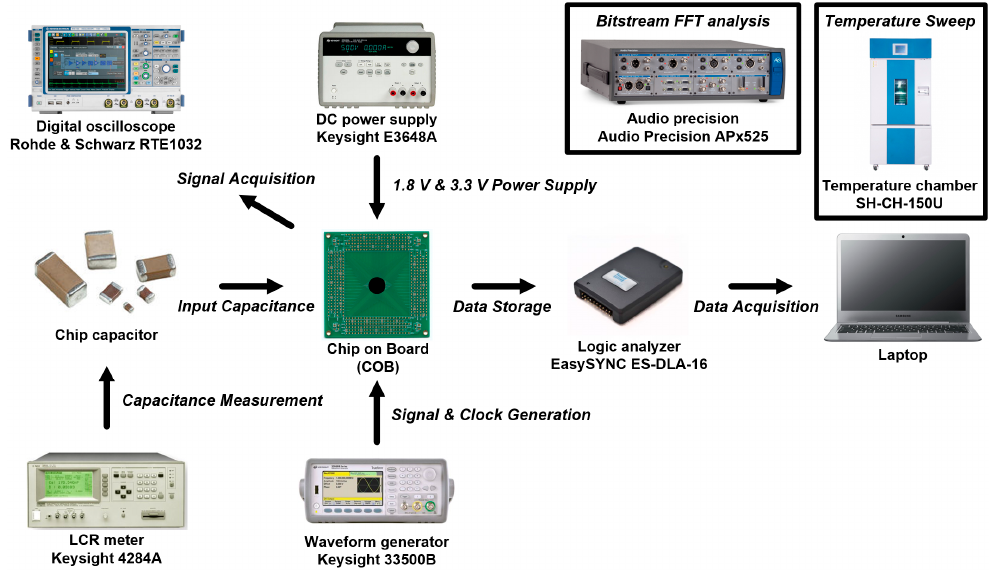
Figure 10. Measurement environment of the proposed reconfigurable sensor analog front-end IC.